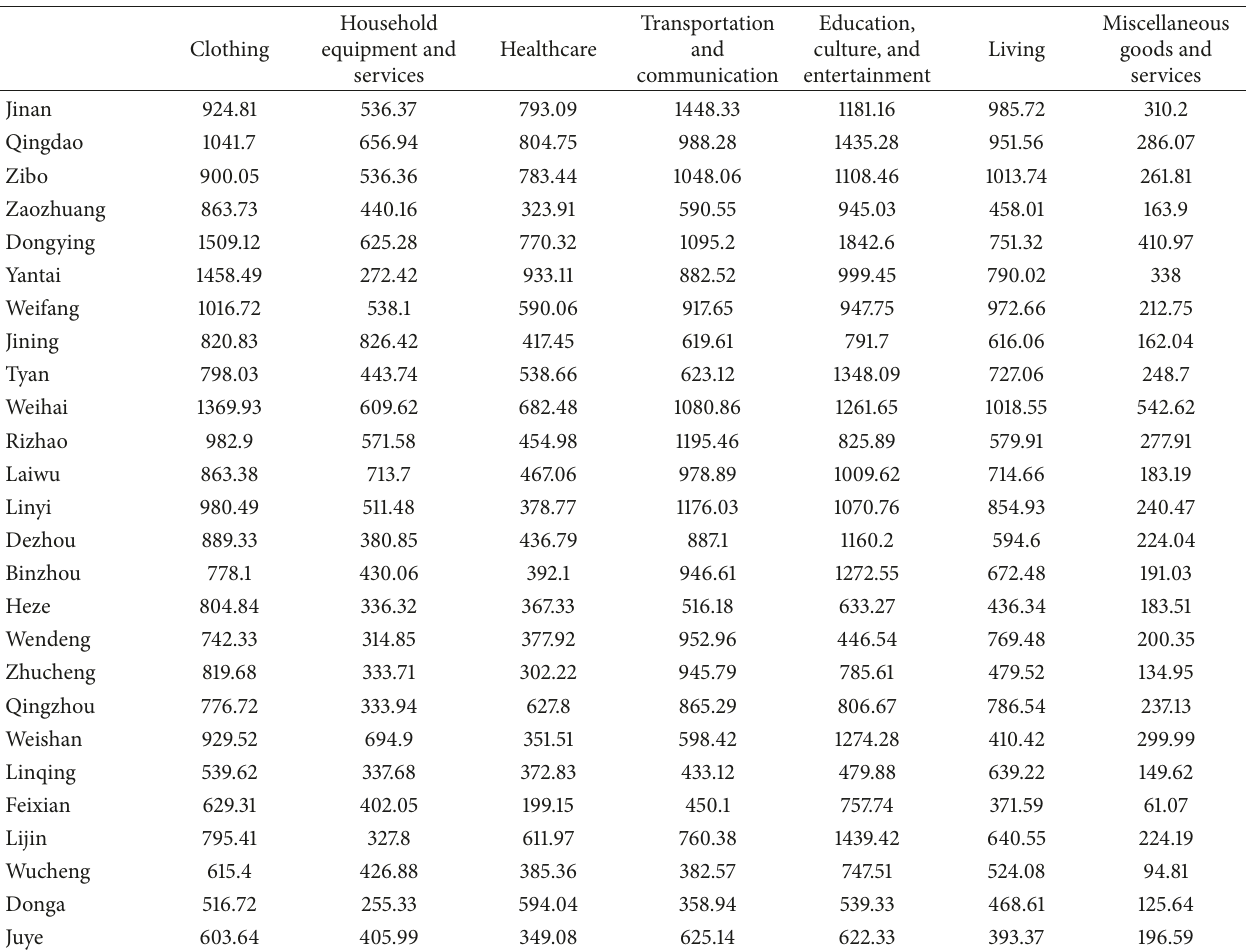
Table 2: Consumption data of 26 regions in Shandong